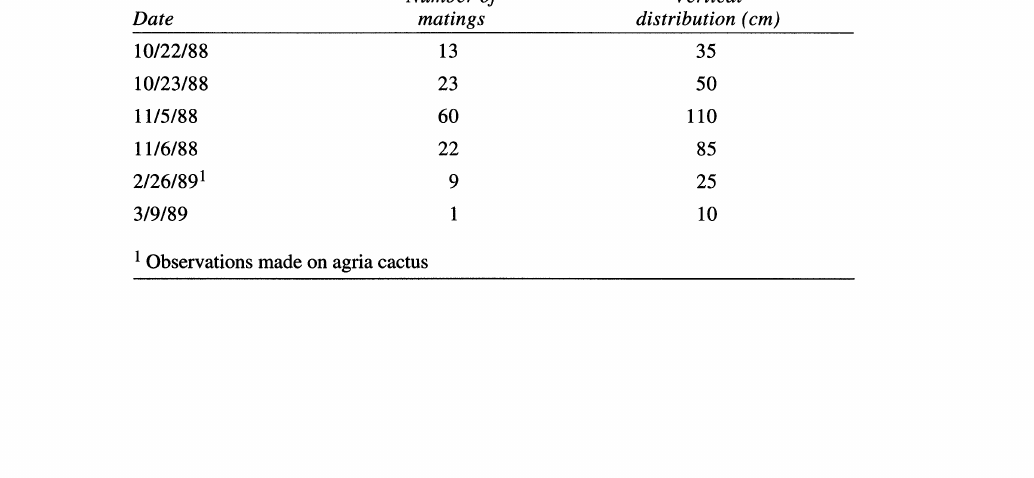
Table 1. Number of matings and vertical distribution of copulating pairs of Drosophila mojavensis along an upright columnar cactus arm. Number of Vertical Date